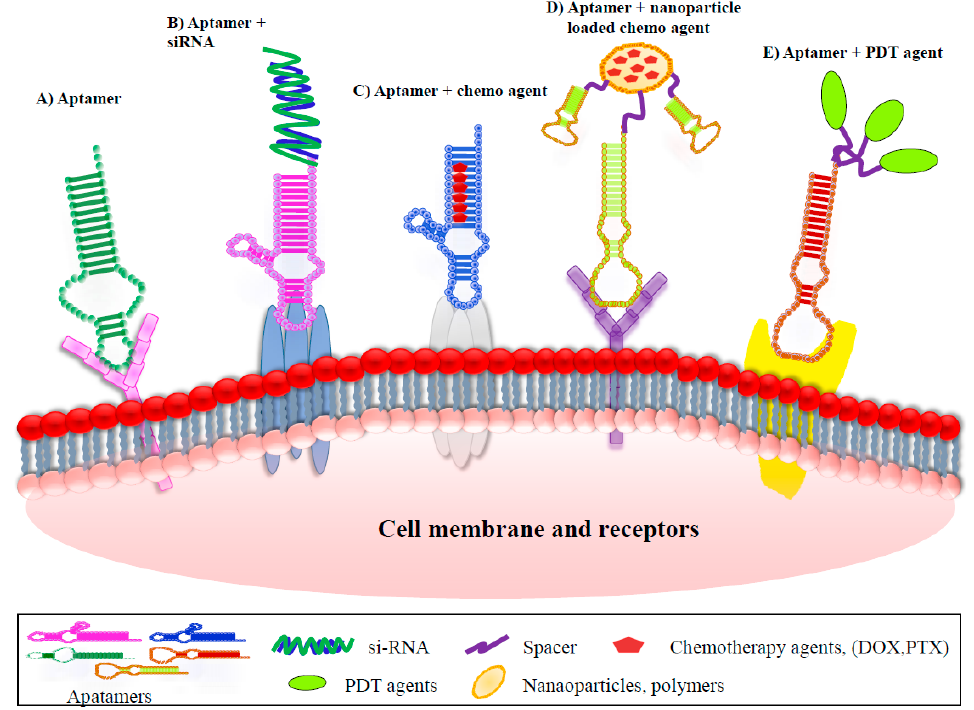
Figure 2. Therapeutic applications of aptamers for breast cancer.